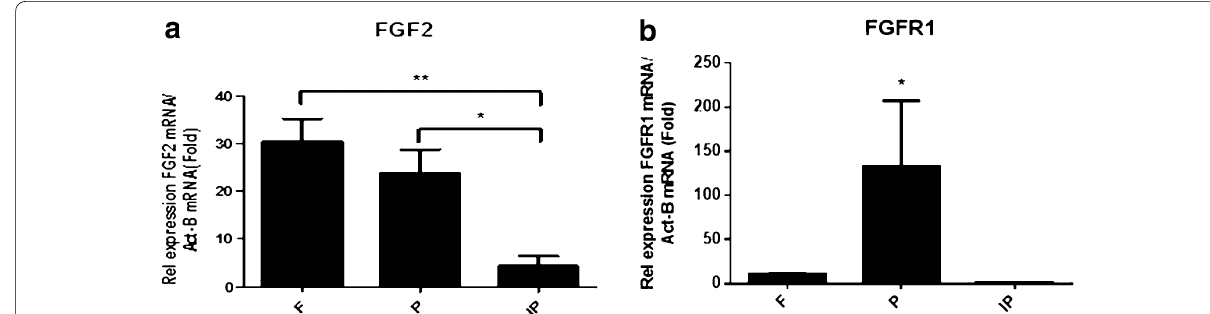
Fig. 6 TaqMan analysis of skeletogenesis markers: FGF2 and FGFR1 expression in calvariae of C57BL/KalwRiJHsD mice. RNA was extracted with cDNA synthesized from frontal (F), parietal (P) and interparietal (IP) bones. The relative expression of skeletogenesis marker genes was adjusted to the relative expression of a housekeeping gene, β‑actin. There was a significant increase in the relative expression of FGF2 ( a ) in frontal and parietal bones compared to interparietal bone. In addition, there was no difference in the relative expression of FGF2 between frontal and parietal bones. On the other hand, the relative expression of FGFR1 ( b ) genes was significantly expressed in parietal bone compared to frontal and interparietal